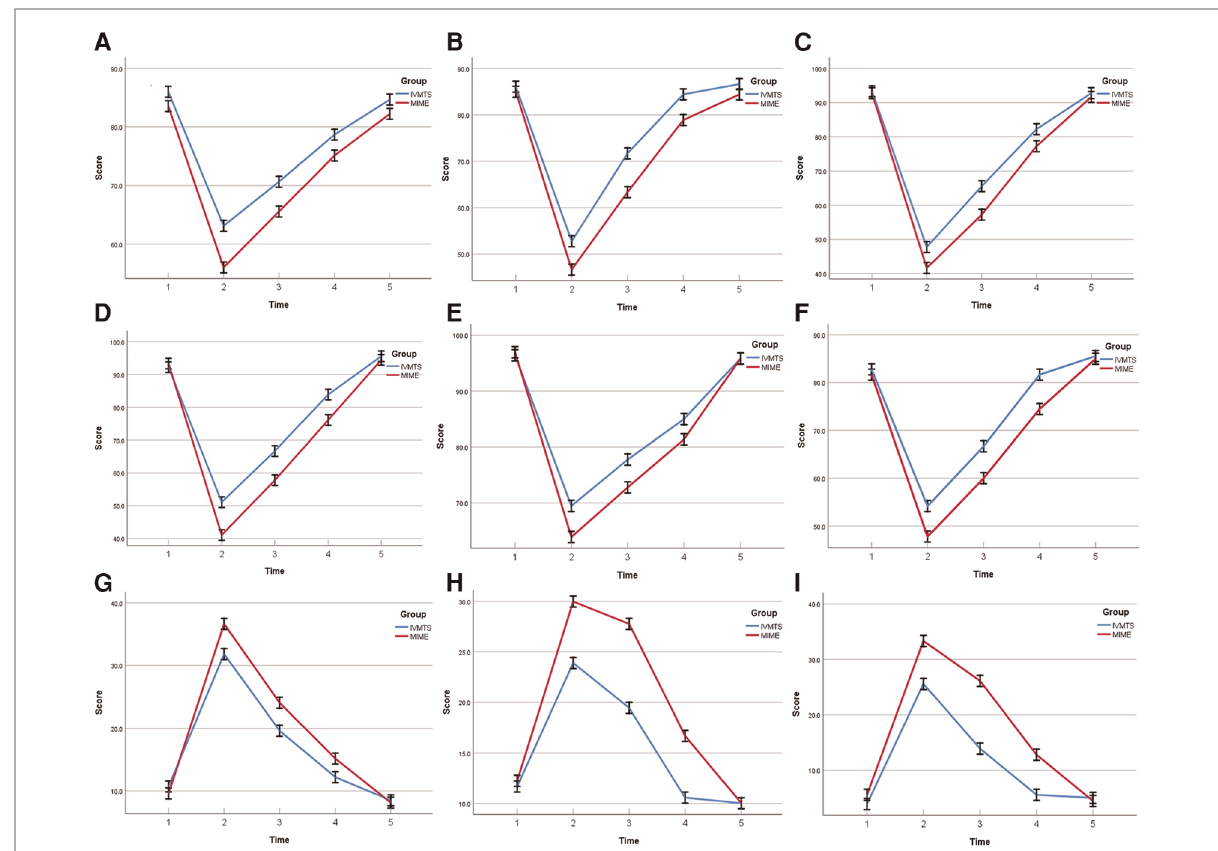
FIGURE 1 Comparison of QLQ-C30 scores between the two groups before and after operation. ( A ) Physical function. ( B ) Role function. ( C ) Cognitive function. ( D ) Social function. ( E ) Emotional function. ( F ) Global health status. ( G ) Fatigue. ( H ) Nausea/vomiting. ( I ) Pain. IVMTE, in fl atable videoasisted mediastinoscopic transhiatal esophagectomy; MIME, minimally invasive Mckeown esophagectomy; Time 1, 1 day before operation; Time 2, 1 weeks after operation; Time 3, 2 weeks after operation; Time 4, 4 weeks after operation; Time 5;, 8 weeks after